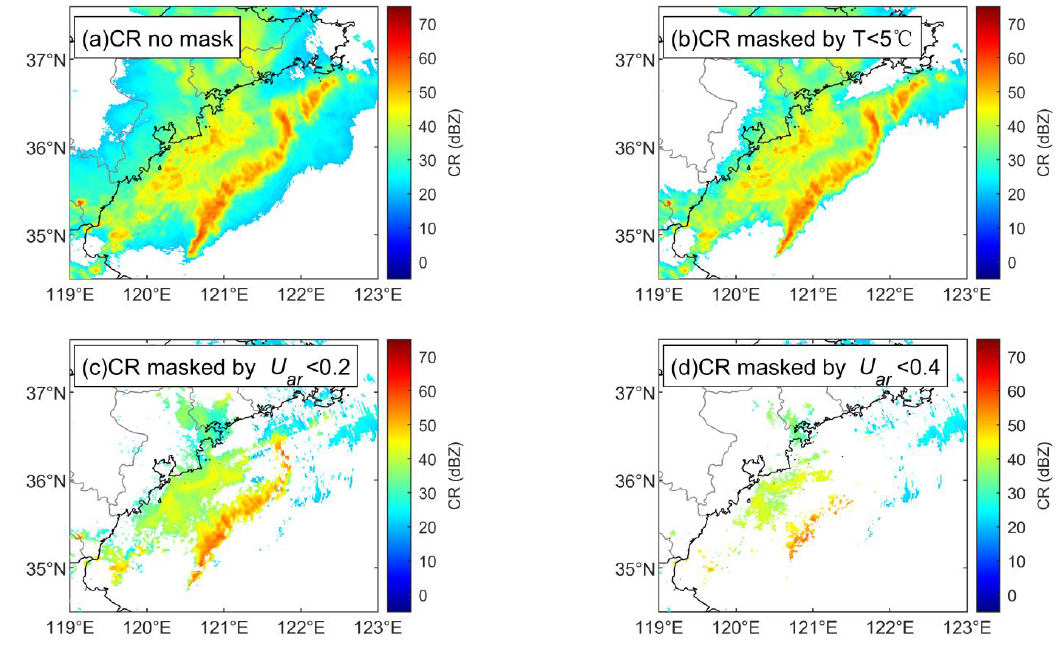
Figure 17. CR with different reflectivity masks. (The points are with Z H > 20 dBZ. The time is the same as Figure 15. ( a ) CR no mask, ( b ) CR masked by T < 5 °C, ( c ) CR masked by U ar < 0.2, ( d ) CR masked by U ar < 0.4.